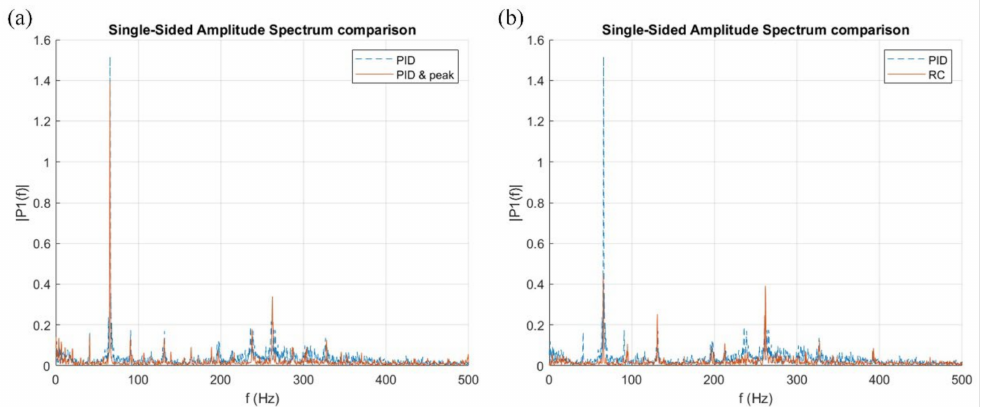
Figure 12. Force amplitude spectrum of the grinding tool using ( a , b ) PID force control, ( a ) PID force control with peak filter (PID & peak), and ( b ) repetitive control